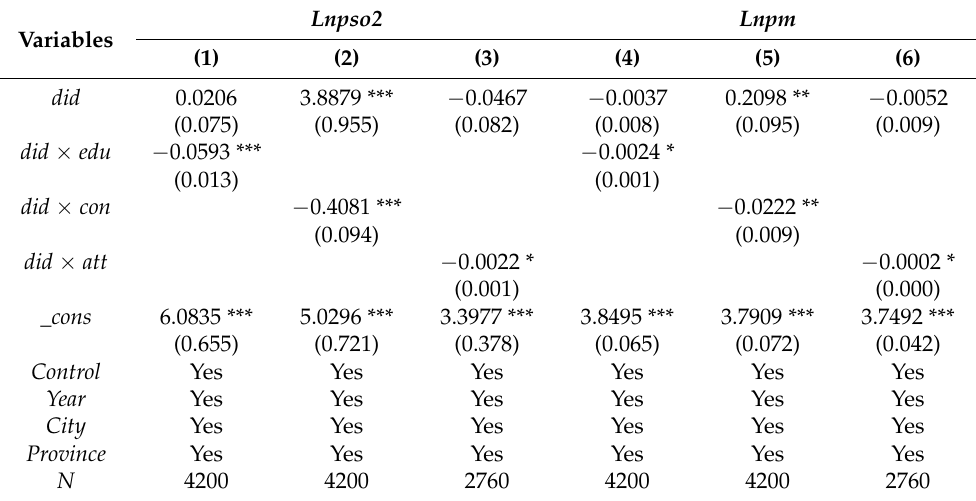
Table 9. Tests of the moderating effect of public